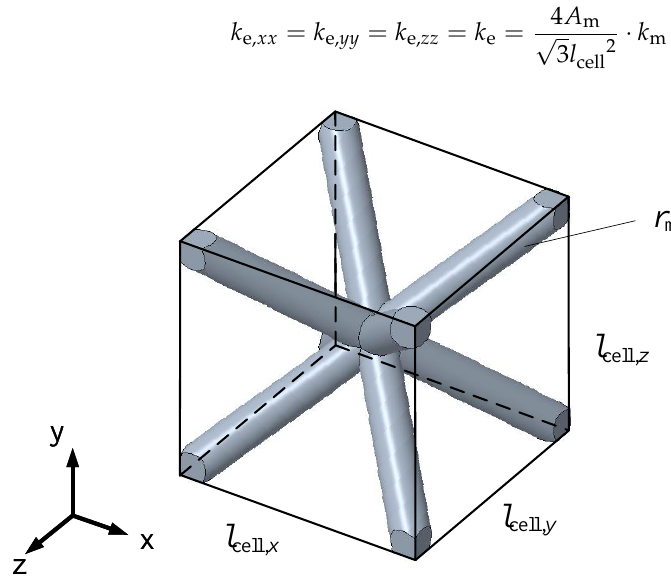
Figure 4. A single cell of BCC type lattice